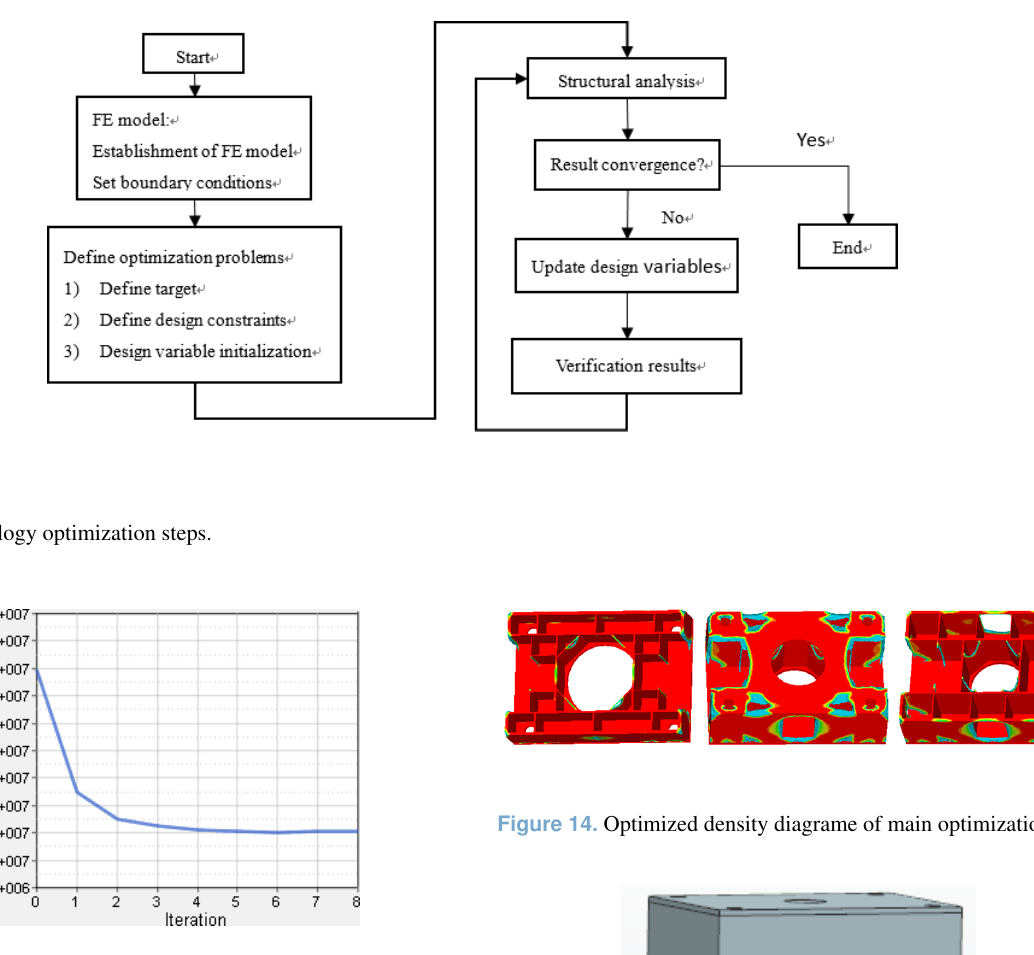
Figure 12. Convergence process graph of objective function.